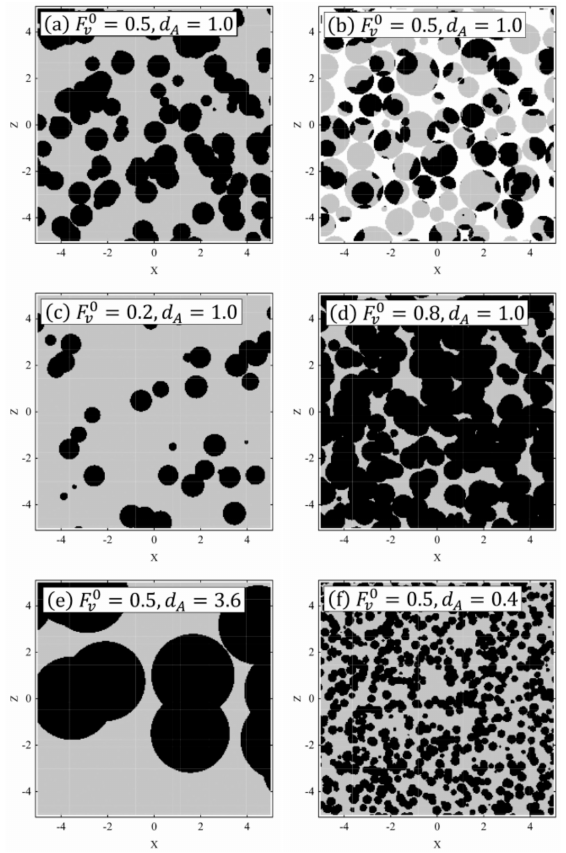
Figure 3. Partial sectional images of the binary structure created by the Boolean model: ( a ) phase A volume fraction ( F 0 v ) = 0.5, phase A element diameter ( d A ) = 1.0; ( b ) after particle hollowing of ( a ); ( c ) F 0 v = 0.2, d A = 1.0; ( d ) F 0 v = 0.8, d A = 1.0; ( e ) F 0 v = 0.5, d A = 3.6; and ( f ) F 0 v = 0.5, d A =